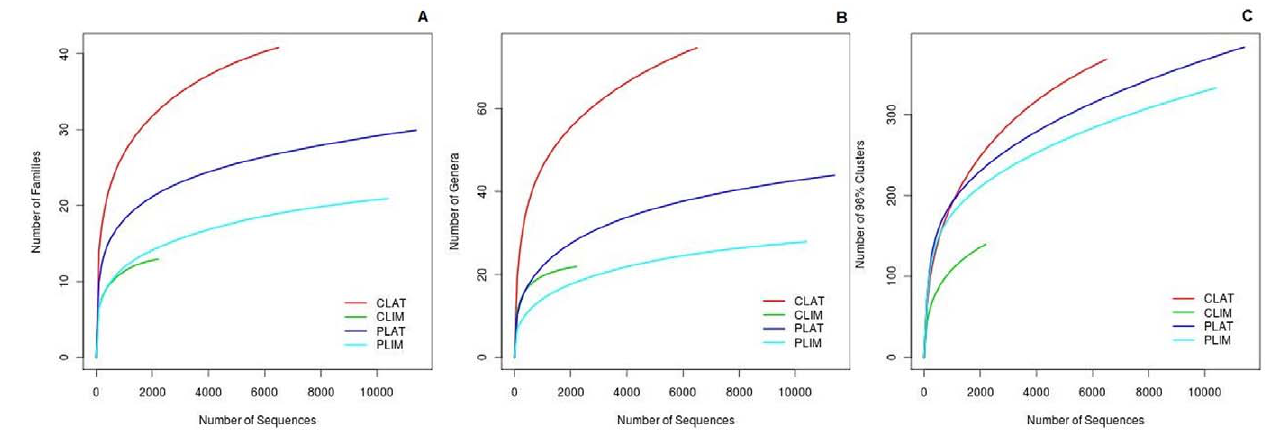
Figure 2. Rarefaction curves calculated at family (a), genus (b) and phylotype (clustering at 98% of identity) (c) levels. CLAT, C. latum larvae; CLIM, C. limbipenne larvae; PLAT, C. latum cactus medium; PLIM, C. limbipenne cactus medium.